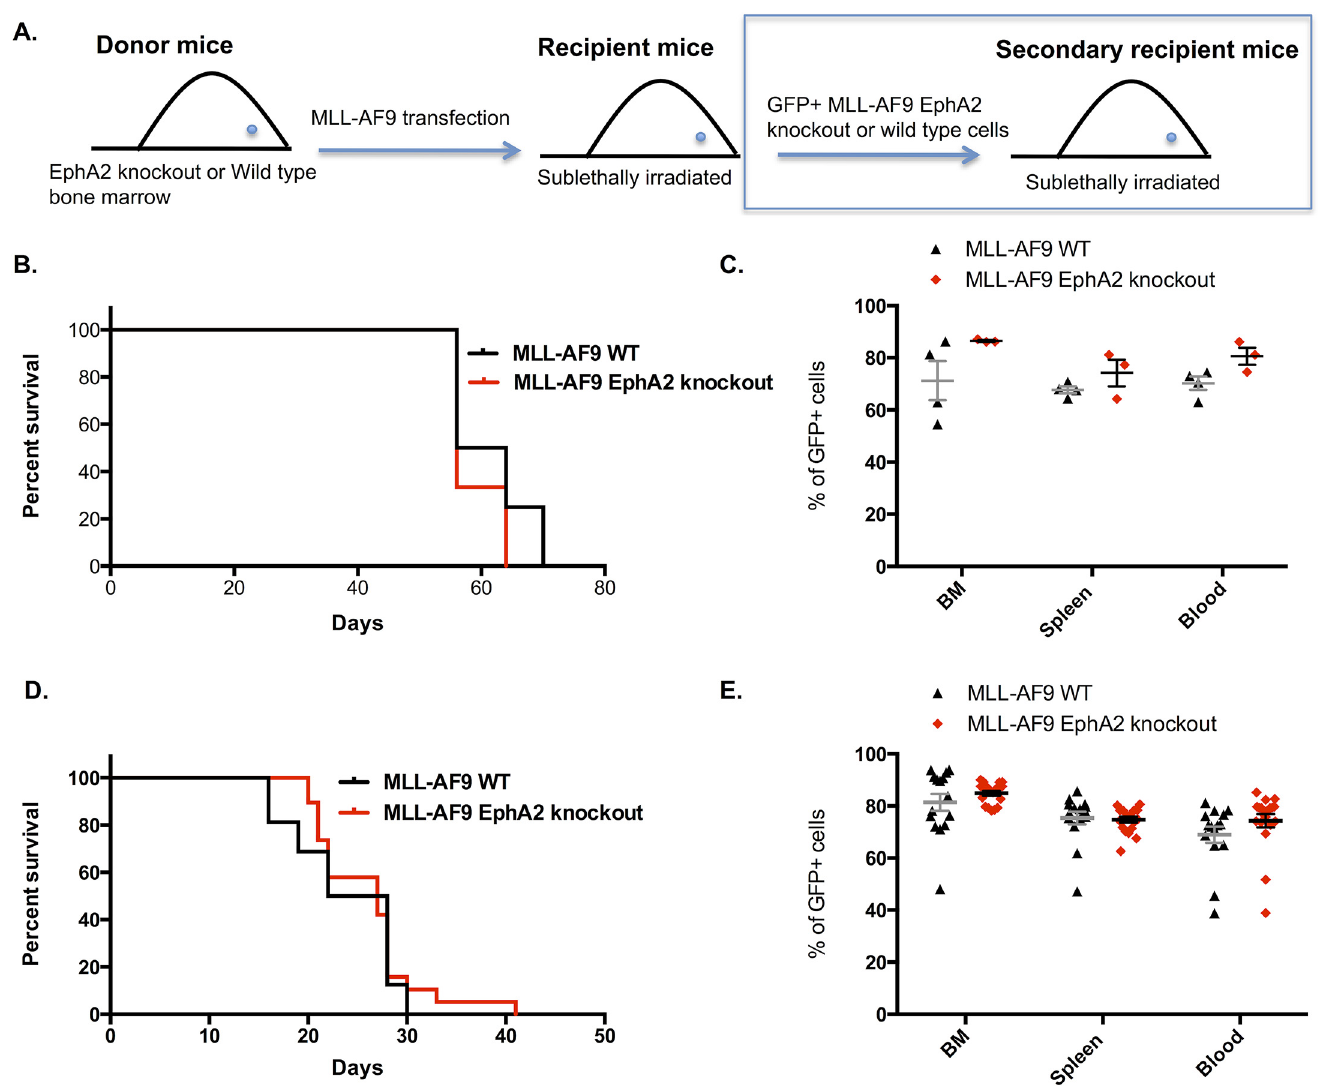
Fig 5. MLL-AF9 EphA2 knockout mice have similar leukemogenic potential. ( A ) Serial MLL-AF9 leukemic transplantation model. ( B ) Survival of leukemic mice transplanted with EphA2 knockout MLL-AF9 – transduced hematopoietic stem cells (LKS + ) compared to wild type MLL-AF9 – transduced hematopoietic stem cells (LKS + ) showed no significant differences between the two groups (n = 4 wild type, n = 3 EphA2 knockout, 2 independent experiments). ( C ) Percentage of GFP + cells in bone marrow, spleen and blood of the EphA2 knockout and wild type MLL-AF9 bone marrow, spleen and blood at time of cull did not show any significant differences between the two groups. ( D ) Survival of secondary MLL-AF9 mice transplanted with GFP + EphA2 knockout or GFP + wild type MLL-AF9 cells from the primary transplant showed no significant differences between the two groups (n = 16 wild type, n = 19 EphA2 knockout, 4 independent experiments). ( E ) Percentage of GFP + cells in bone marrow, spleen and blood of the secondary transplanted wild type or EphA2 knockout MLL-AF9 mice did not show any significant differences between the two groups. Each dot corresponds to one individual mouse. The data represent the mean ± SEM. Unpaired t test was performed for statistical analyses. The survival is presented as Kaplan-Meier survival curves (Log rank test was used for statistical